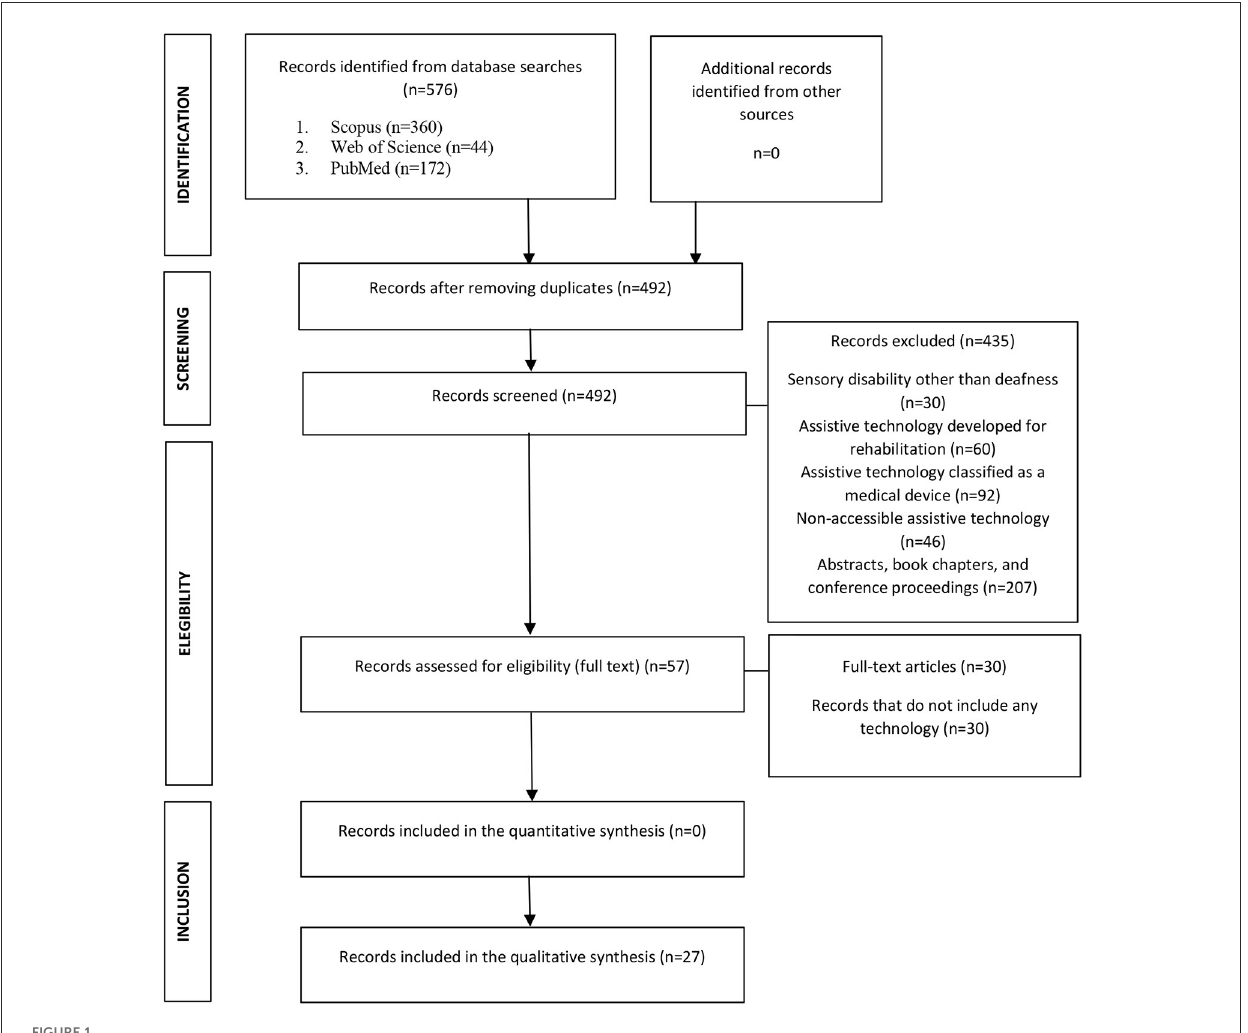
FIGURE1 Flow diagram of the identification and selection